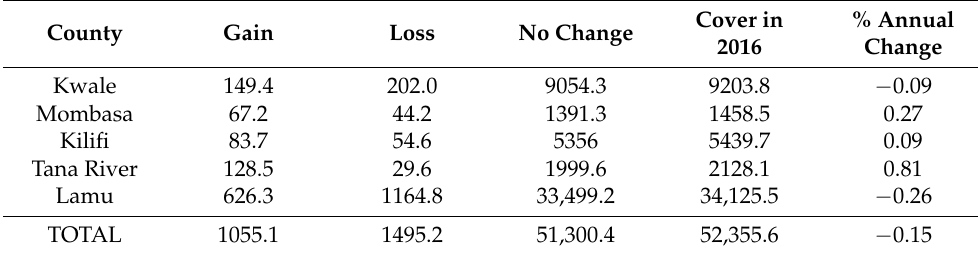
Table 2. Changes in mangrove cover in Kenyan coastal counties (in ha) between 2010 and